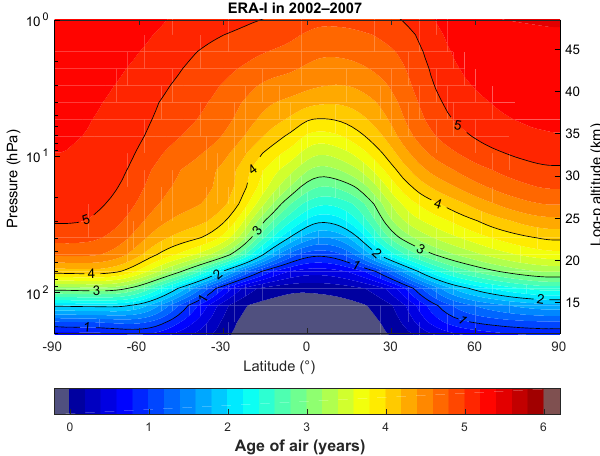
Figure 2. Latitude–pressure distribution of AoA in 2002–2007 from the BASCOE simulation driven by